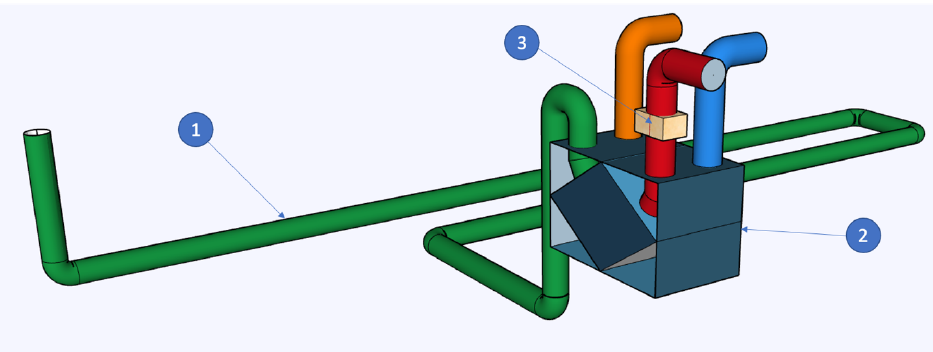
Figure 6. East Passive House, HVAC system. (1) Earth-to-Air Heat Exchanger; (2) Mechanical Ventilation Heat Recovery Unit; (3) electric